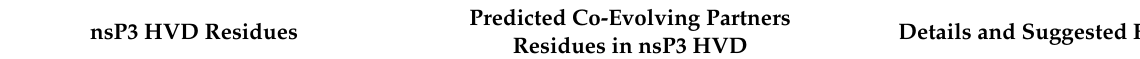
Table 2. List of nsP3 HVD residues and their predicted co-evolved interacting partners, as discovered in silico by Jaspreet et al. in 2016